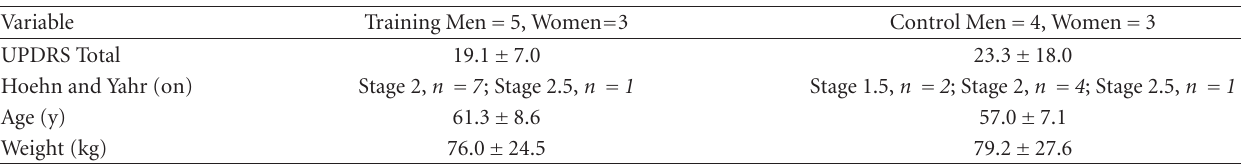
Table 1: Descriptive subject data (mean ±